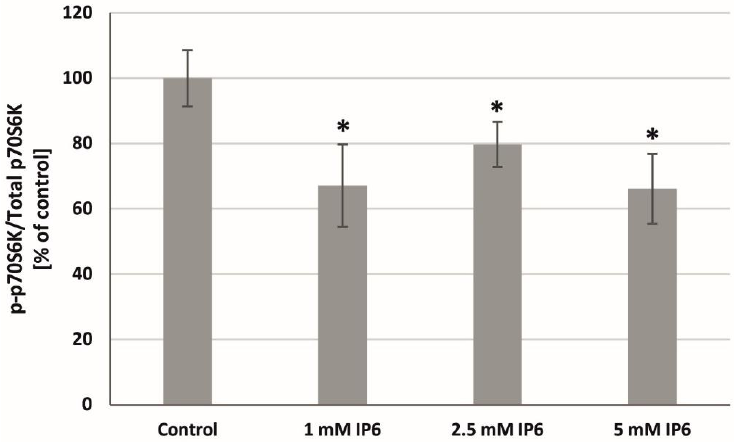
Figure 8. Effect of InsP6 at concentrations of 1 mM, 2.5 mM and 5 mM on the p70S6K activity in Caco-2 cells at 24 h. The results are presented as mean ± SD of three separate experiments; * p < 0.05 vs. control.